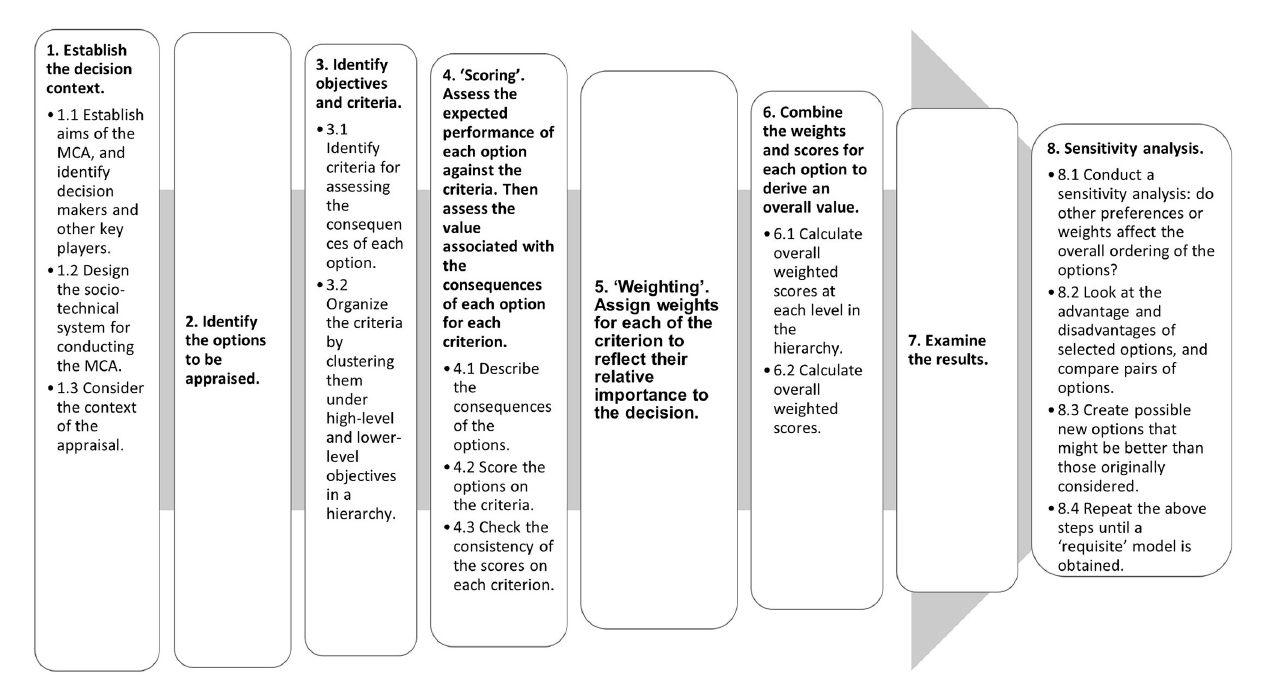
FIGURE1 Flowchart (from left to right) of the MCDA tool (adopted from DCLG,